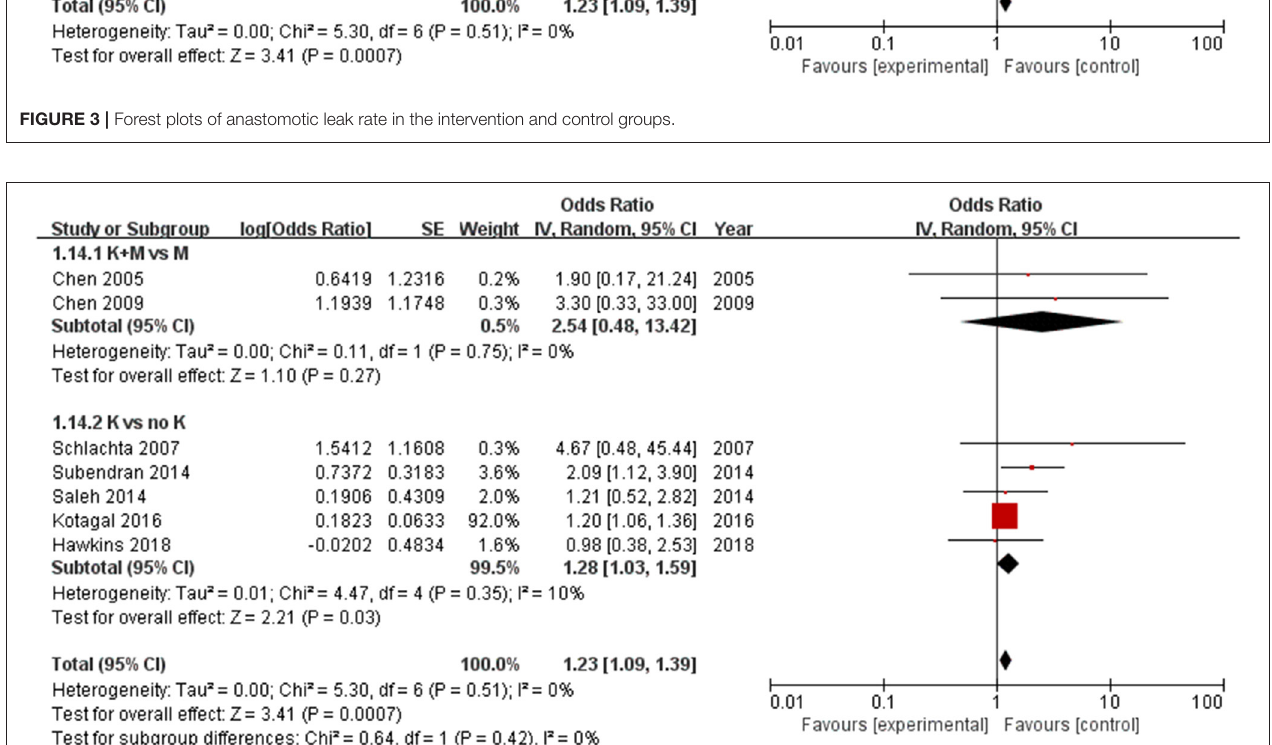
increased with the use of ketorolac ( n = 400,699) (OR =